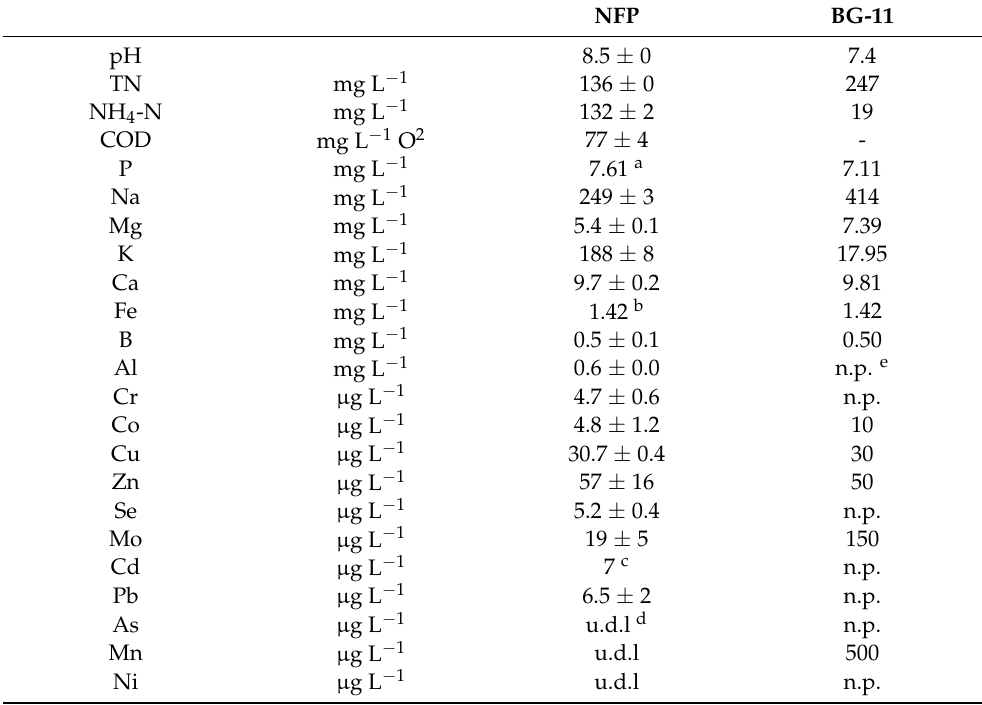
Table 1. NFP chemical characterization vs. BG-11 nutrient